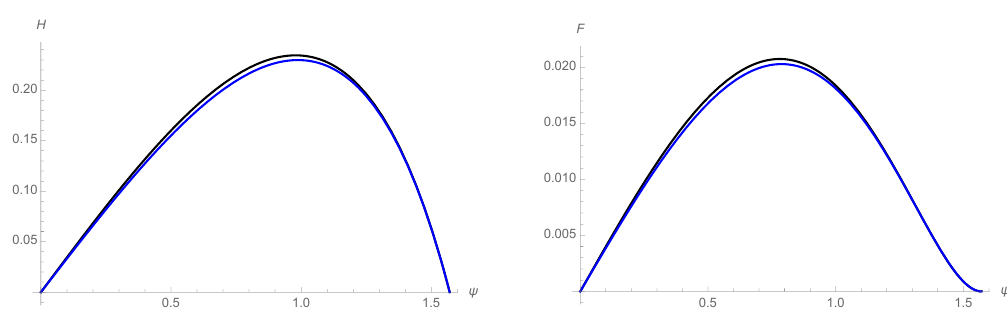
Figure 1 : Numerical solutions for H ( ψ ) and F ( ψ ) are shown in black (the values e = 1 , = 1 have been used). As a comparison, the analytical approximations (2.18) are shown α H in